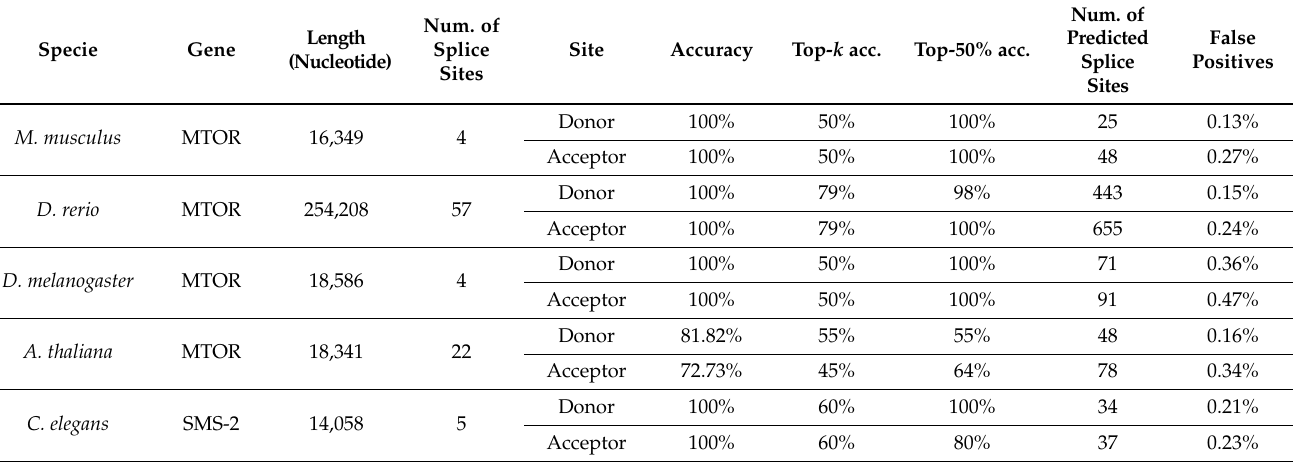
Table 9. Prediction results of other species’ genes evaluated using Deep